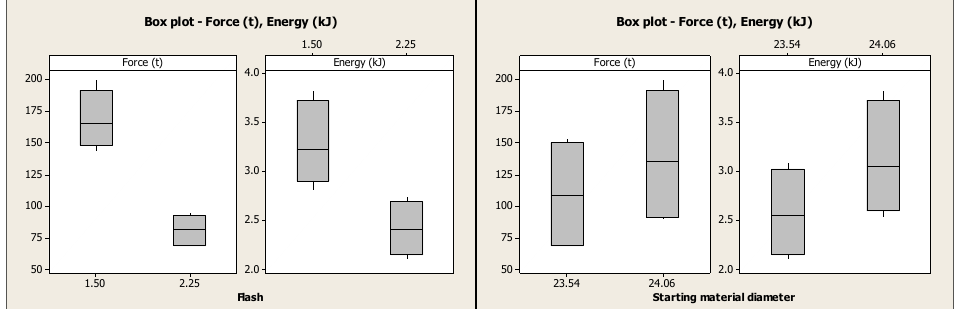
Figure 5. Box plots for the analyzed process parameters.